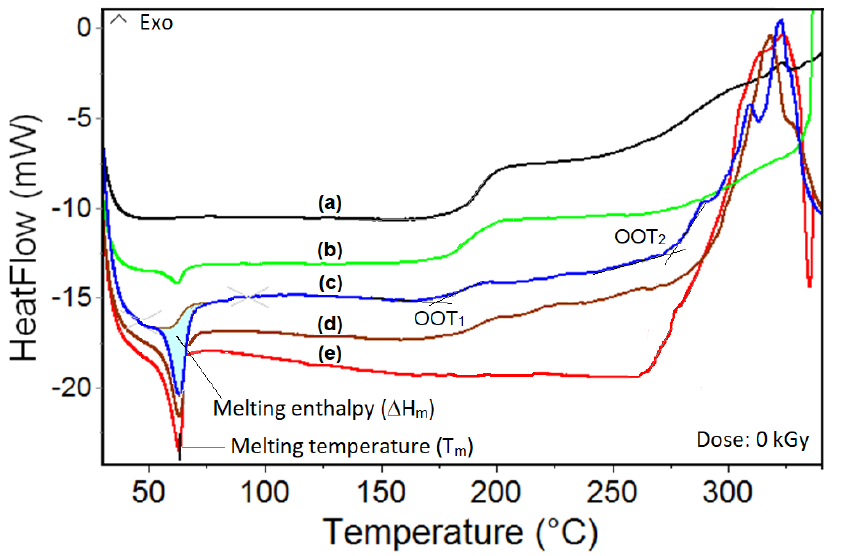
Figure 8. Non-isothermal, DSC curves recorded on: (a) Neat SIS; (b) SIS:PCL = 3:1; (c) SIS:PCL = 1:3;. (d) SIS:PCL = 1:1; (e) Neat PCL. Table 2. DSC parameters obtained from DSC curves